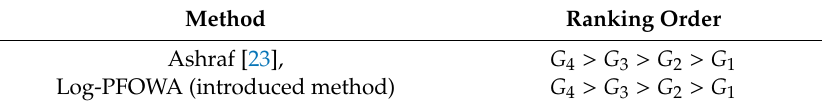
Table 14. Comparison analysis with the existing method